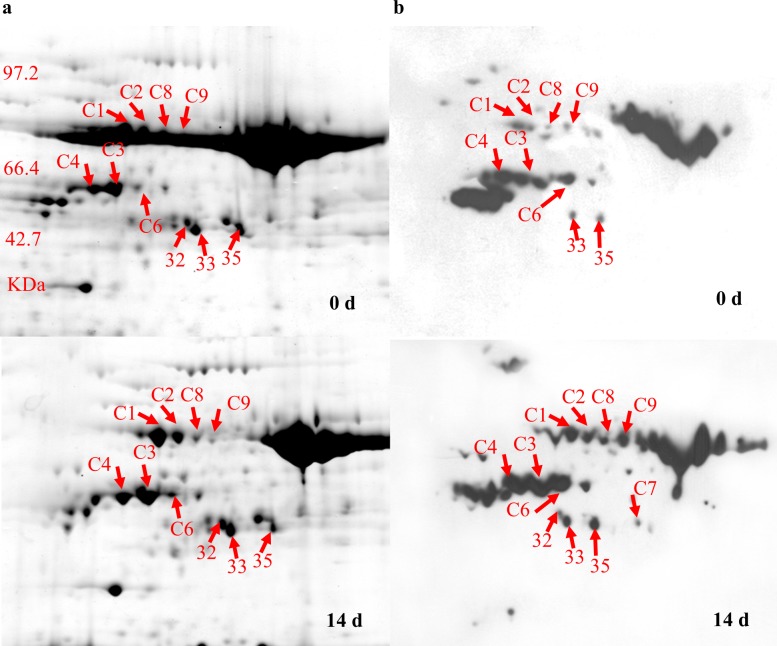
Detection of carbonylated proteins of S. purpurea seedlings. Carbonylated proteins were analyzed by 2D-PAGE.(A) Gels stained to detect proteins. (B) Anti-DNP immunoassays of gels to detect carbonylated proteins. Labeled proteins are listed in Table 2.